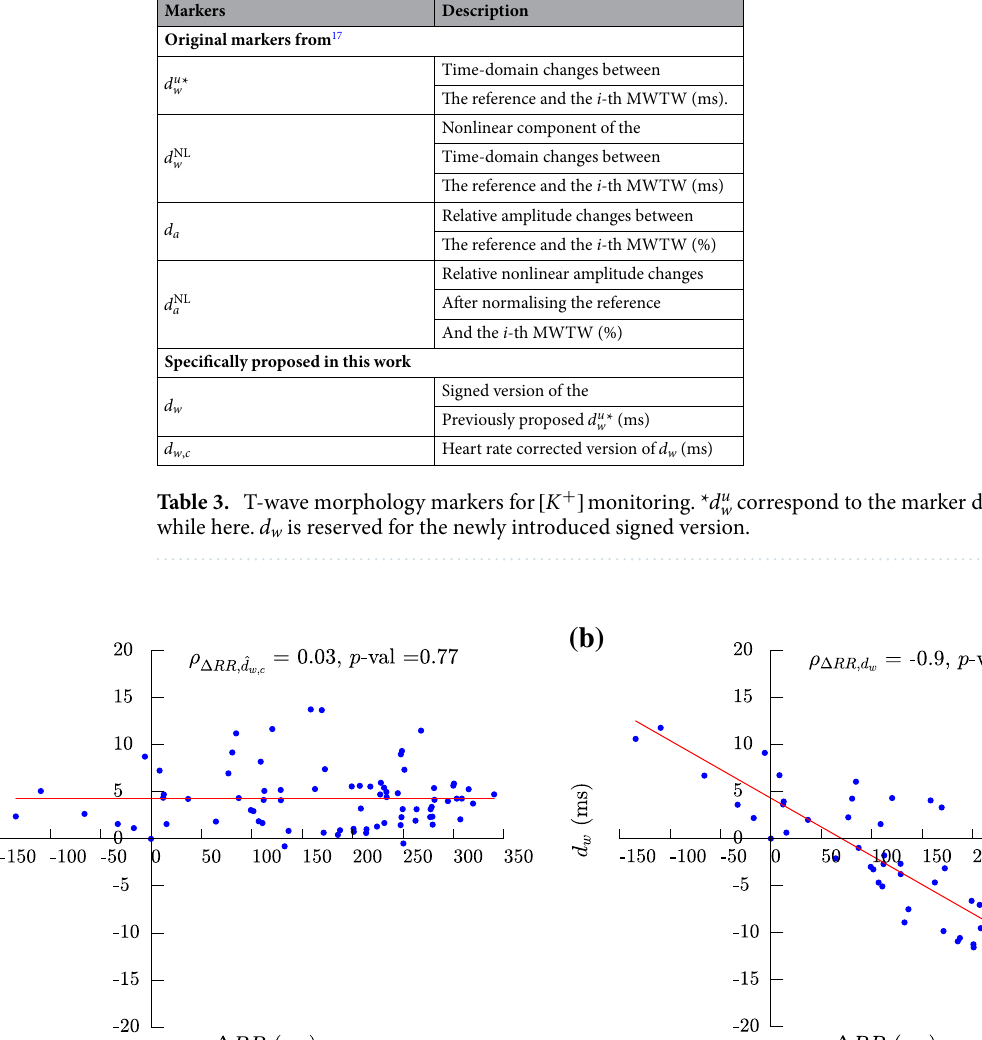
ˆ d w , c panel ( b ) with respect to (cid:31) RR for a given ˆ d w , c are shown on